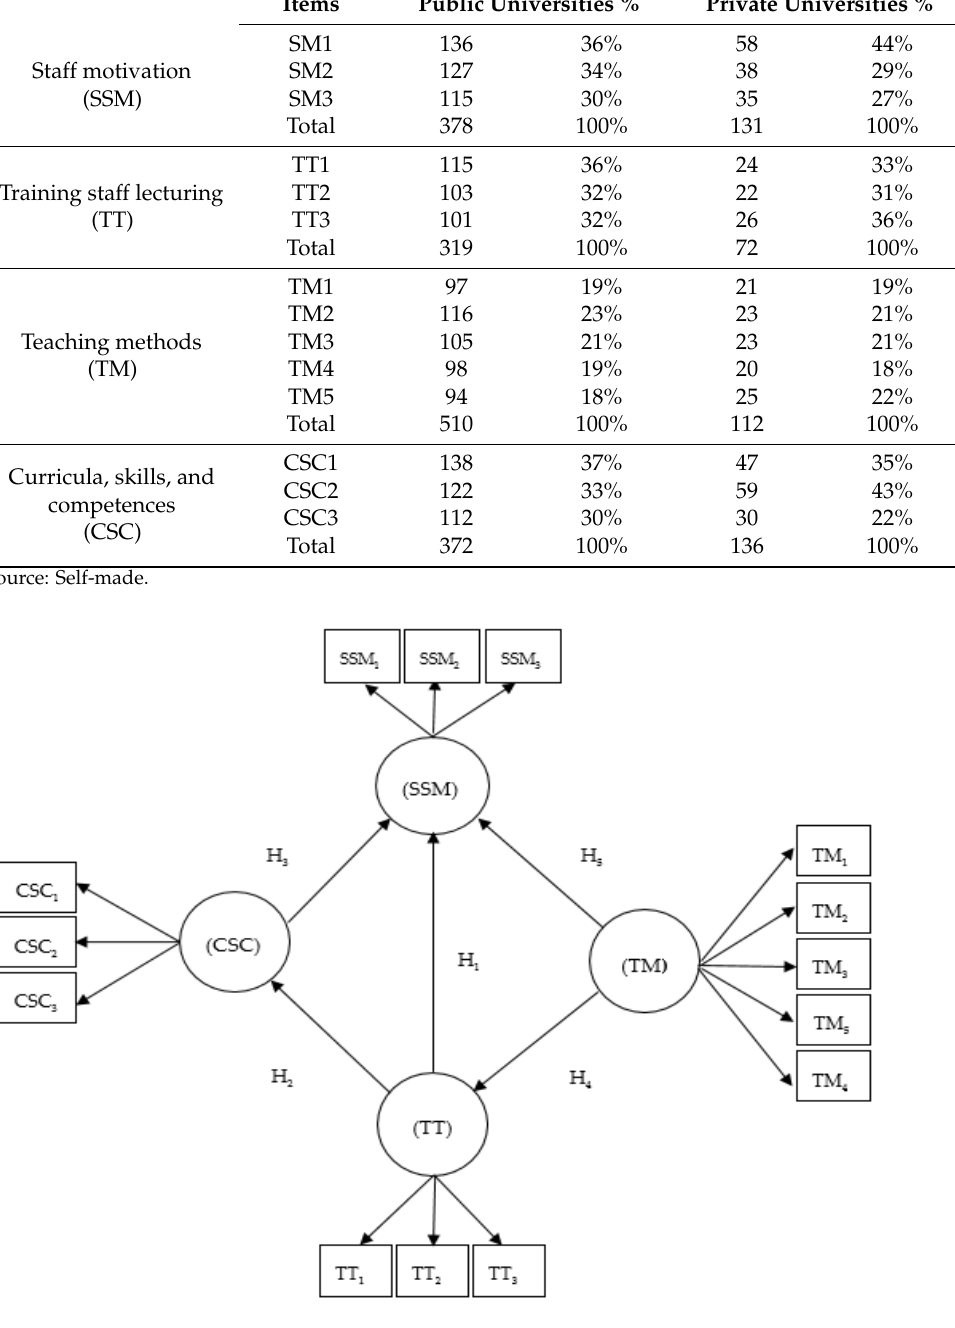
Figure 1. Structural Model (Source: Self-made. SSM: Staff motivation; TT: Training staff lecturing; TM: Teaching methods; and CSC: Curricula, skills, and